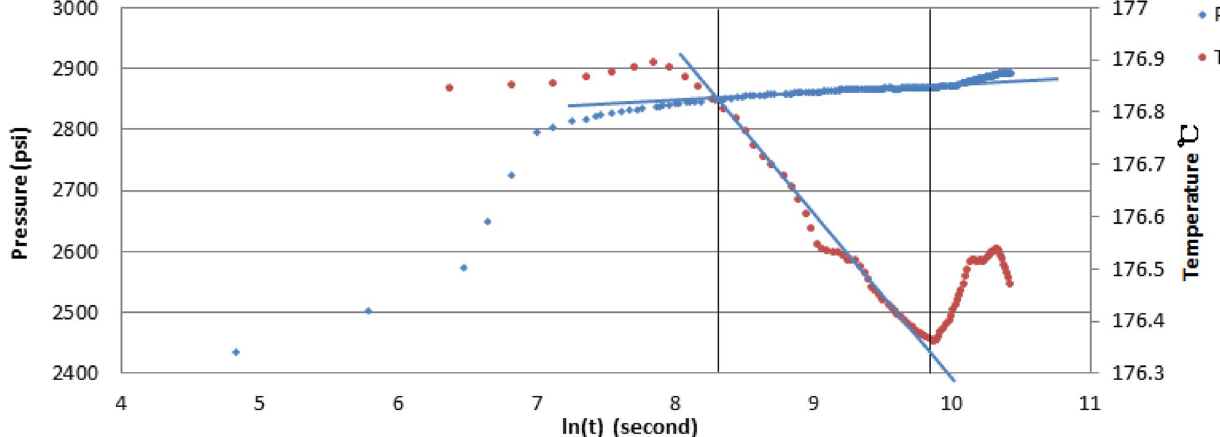
Fig. 13 TTA of transient II: ε ′ = dT / dP = 0.48/20 = 0.024 C/psi